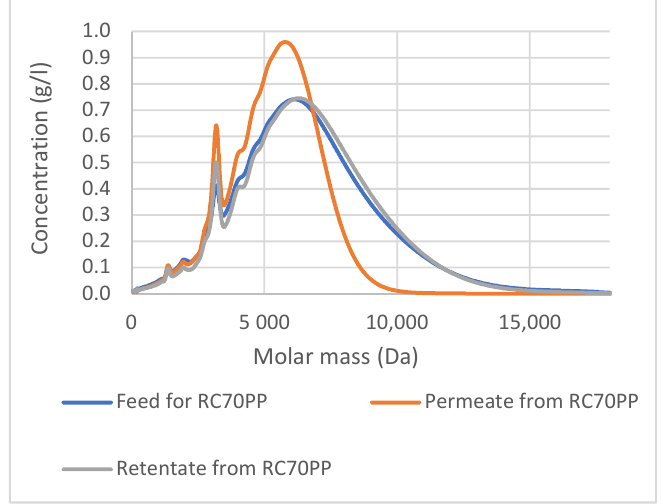
Figure 7. Correlation between molar mass distribution and concentration for the precipitates from the feed, the permeate and the retentate of RC70PP filtration, detected with a UV detector. The other fractions produced in the multistage filtration process contained only minor amounts of lignin compared to the RC70PP retentate. However, to purify the